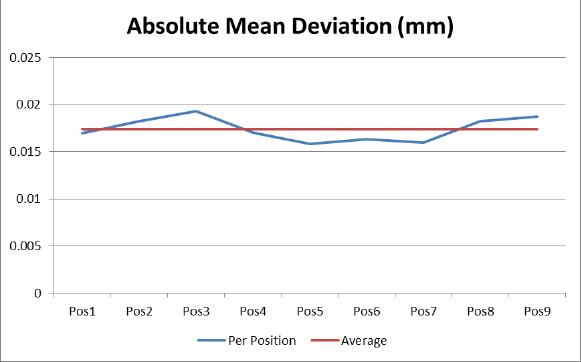
Figure 12. Mean point deviations in mm on sensor platform This shows that the 6Dof Tracking Rig is achieving an average point coordination accuracy of 17µm with a worst case of 20 µm.